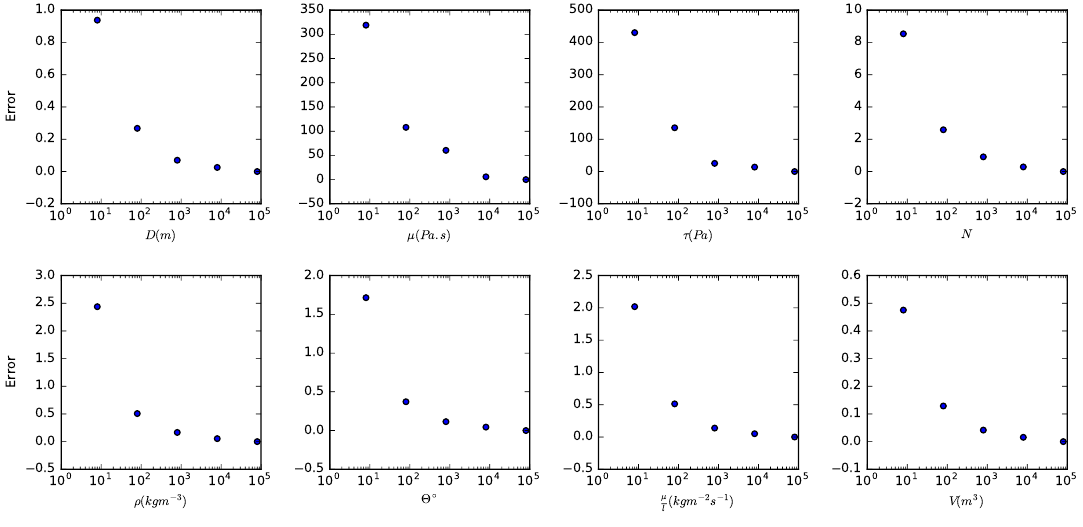
Figure 5. Convergence of values of main Sobol’ indices with increasing samples of the emulator (8, 80, 800, 8000, 80,000). Reasonable convergence was achieved for indices corresponding to each parameter input by 8000 samples.